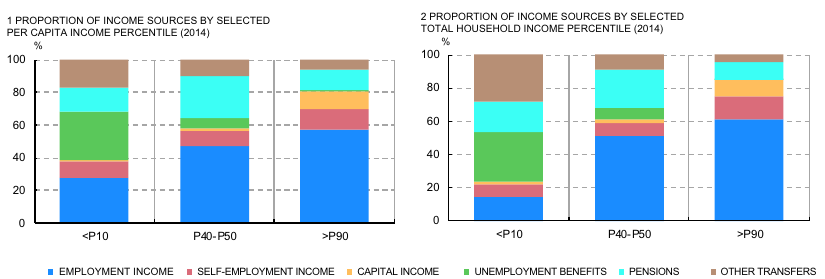
Fig. 4 Sources of income by per capita and total household income percentile (2014). Source : Banco de España (EFF)